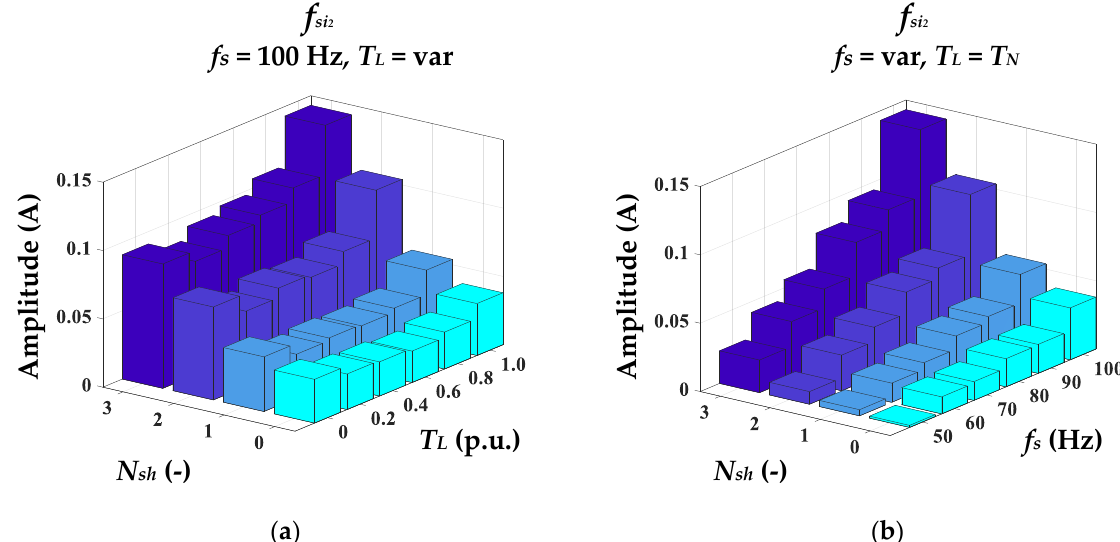
Figure 5. The impact of shorted turns number in the PMSM stator winding on the level of the amplitude of the f si 2 component in the negative phase current sequence component for variable load torque T L ( a ) and variable supply frequency f s ( b ).